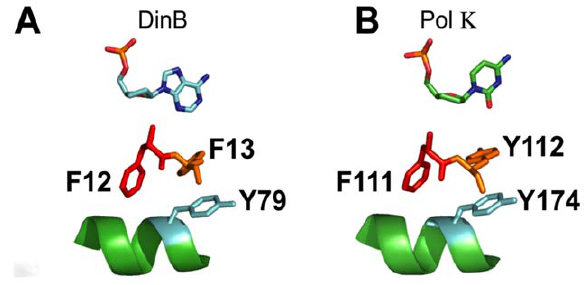
Figure 1. Homologous E.coli DinB and human Pol k aromatic triads appear similarly positioned in the active site. The near identical conformation of the aromatic triads of ( A ) DinB (Pol IV) (F12, F13 and Y79) and ( B ) Pol k (F111, Y112, and Y174) suggests these residues could be required for TLS activity of Pol k . The DinB structure is from an in silico model generated in collaboration with A. Abyzov and V. Ilyin [40]. Image generated using PyMOL (DeLano, W.L. The PyMOL Molecular Graphics System (2002) DeLano Scientific, San Carlos, CA, USA.). Pol k structure was rendered using the pdb 3IN5 with PyMOL.